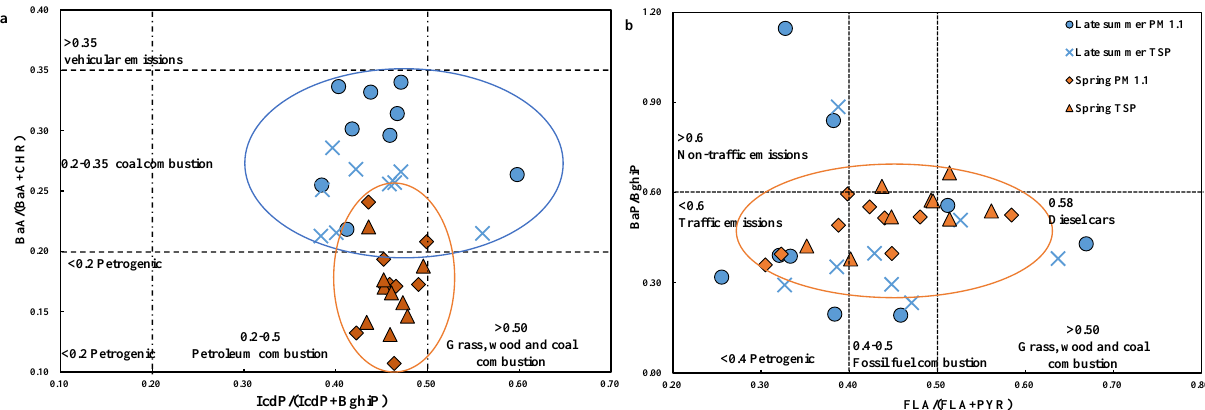
Figure 3. Diagnostics ratio cross plotting in PM 1.1 and TSP, ( a ) IcdP/(IcdP+BghiP) and BaA/(BaA+CHR), ( b ) FLA/(FLA+PYR) and BaP/BghiP. Table 4. PCA loading factors for PAH compounds in fine particles of PM 1.1 during the spring and late summer sampling periods.